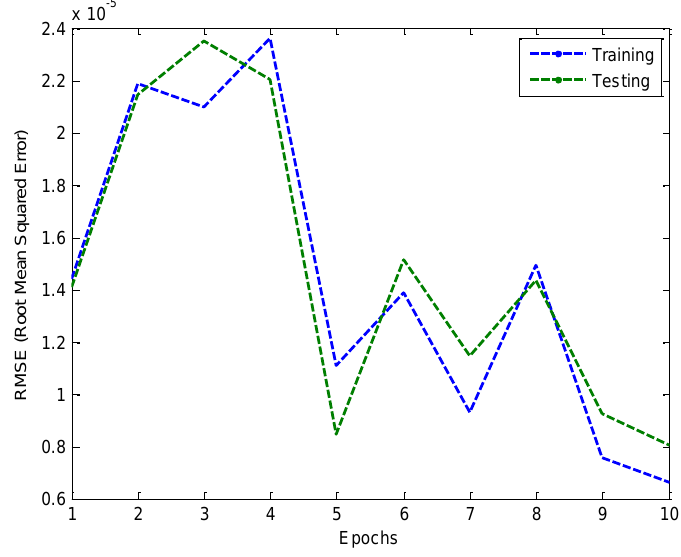
Figure7. Training and testing RMSE with epoch